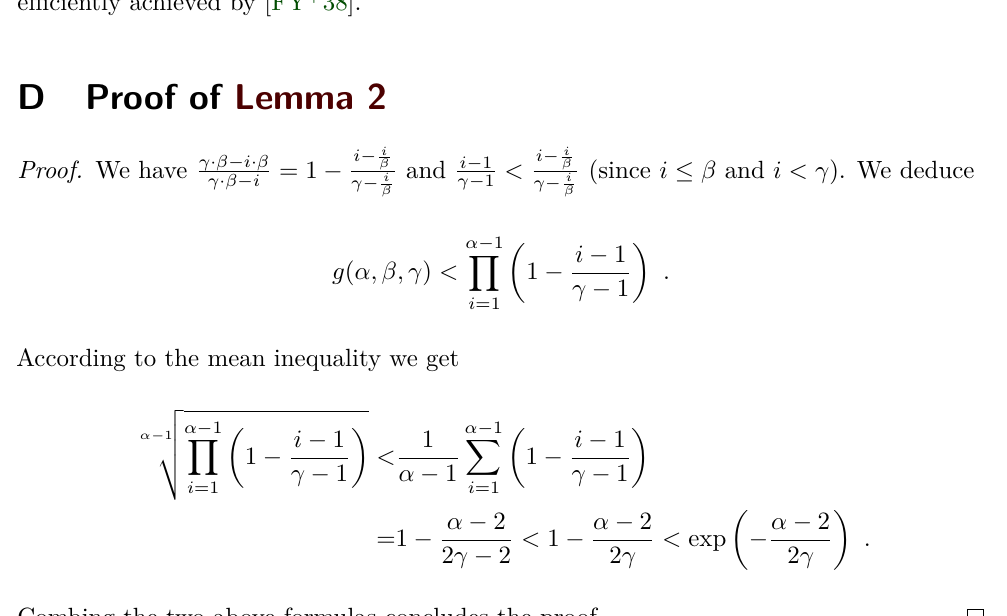
Figure 9: DCA simulation procedures for a ( n, m ) selection function ϕ with N trails. Here K = F n , and ε ← E means randomly sampling a m -bit permutation, which can $ 2